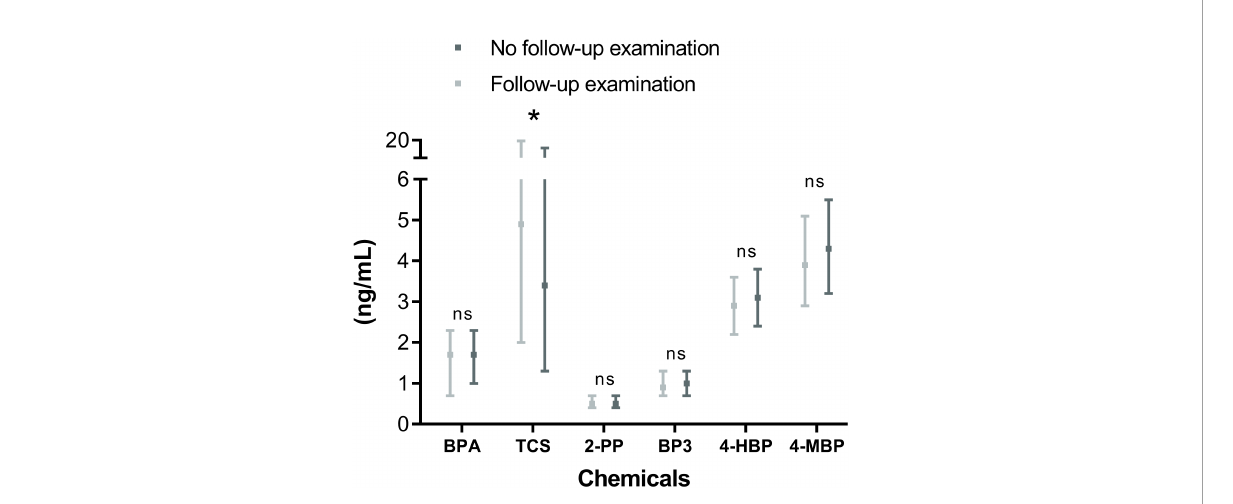
FIGURE 2 Comparison of chemical levels in pregnancy serum samples from mothers with sons with (n=100) or without (n=263) a follow-up examination. P-values <0.05 are indicated by an asterisk. BPA, bisphenol A; TCS, triclosan; 2-PP, 2-phenylphenol; BP-3, benzophenone-3; 4-HBP, 4- hydroxy-benzophenone; 4-MBP,